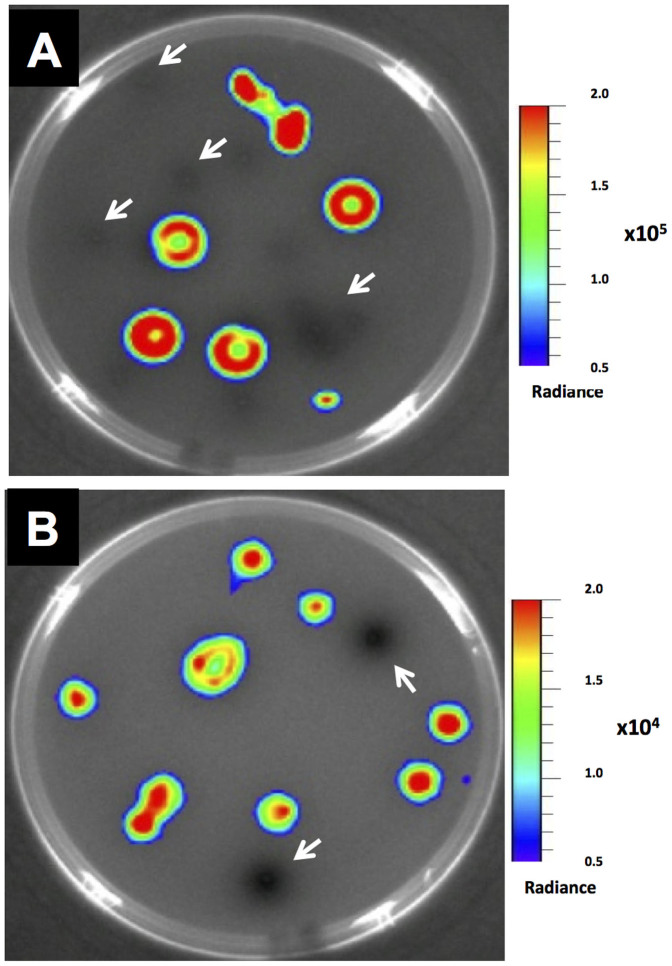
Bioluminescence imaging of CylLS (A) and GBAP (B) producers on BEA.The white arrows indicate cells that were unable to produce CylLS (A) or GBAP (B). After overnight incubation at 37°C, plates seeded with a mixed population of CylLs and GBAP producers were overlaid with the JH2-2 CBS (A) or V583fsrB* GBS (B), following additional incubation for 3 hours. Imaging was performed with a Xenogen IVIS Lumina II Imaging System (Calipers Corp., CA).